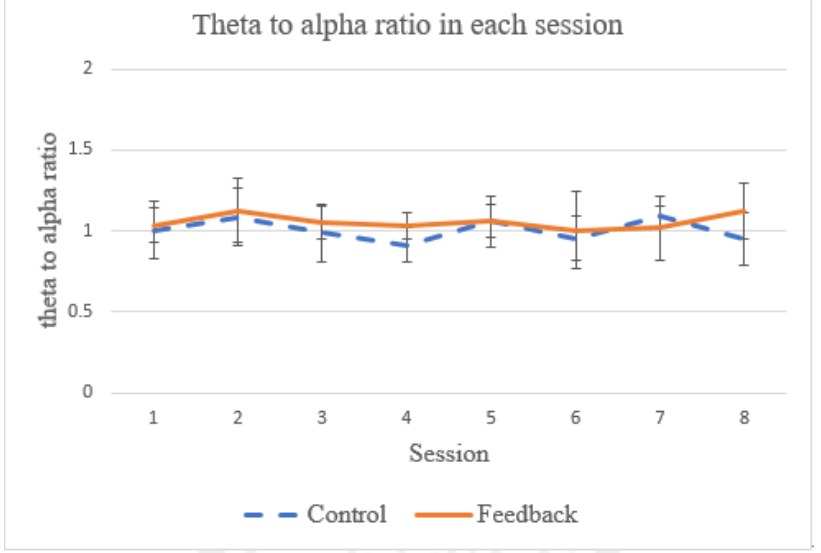
Figure 12. The average theta-to-alpha ratio in each session.